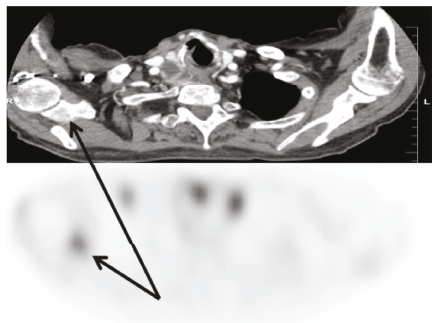
Figure 2: CT scan (a) shows one of the bone lesions that has increased tracer uptake on the (99m)Tc-sestamibi scan